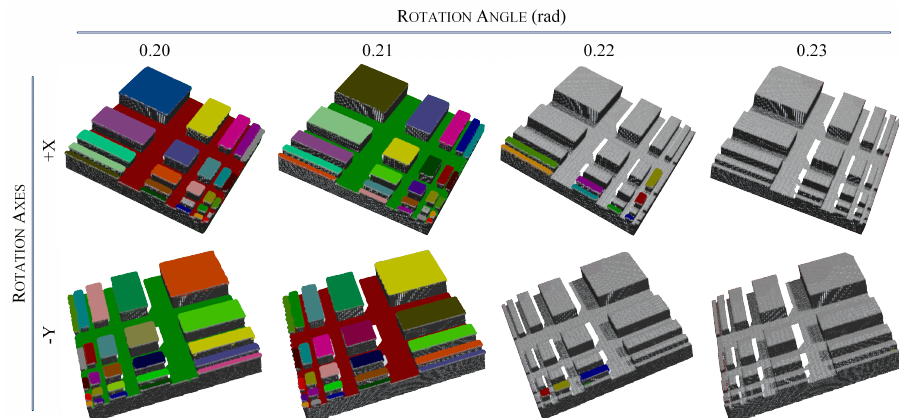
Figure 9. Results of the proposed method extracting multiple horizontal planes in the synthetic scene. Due to the thresholds configuration, planes with tilt angle less than 0.2187 rad were still considered as horizontal, yielding the extraction results as shown in the left two columns. When the tilt angle was close to the threshold as depicted in the third column, some small patches became false positive since their normals are sparser yet more sensitive to data noise. Nevertheless, the unstable state caused by noise disappeared as the tilt angle continue to increase 0.01 rad as shown in the rightmost column. Best viewed in online color